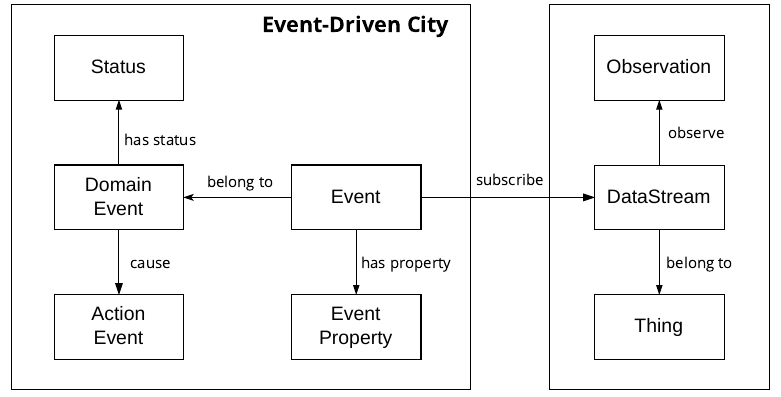
Figure 2. The conceptual model for